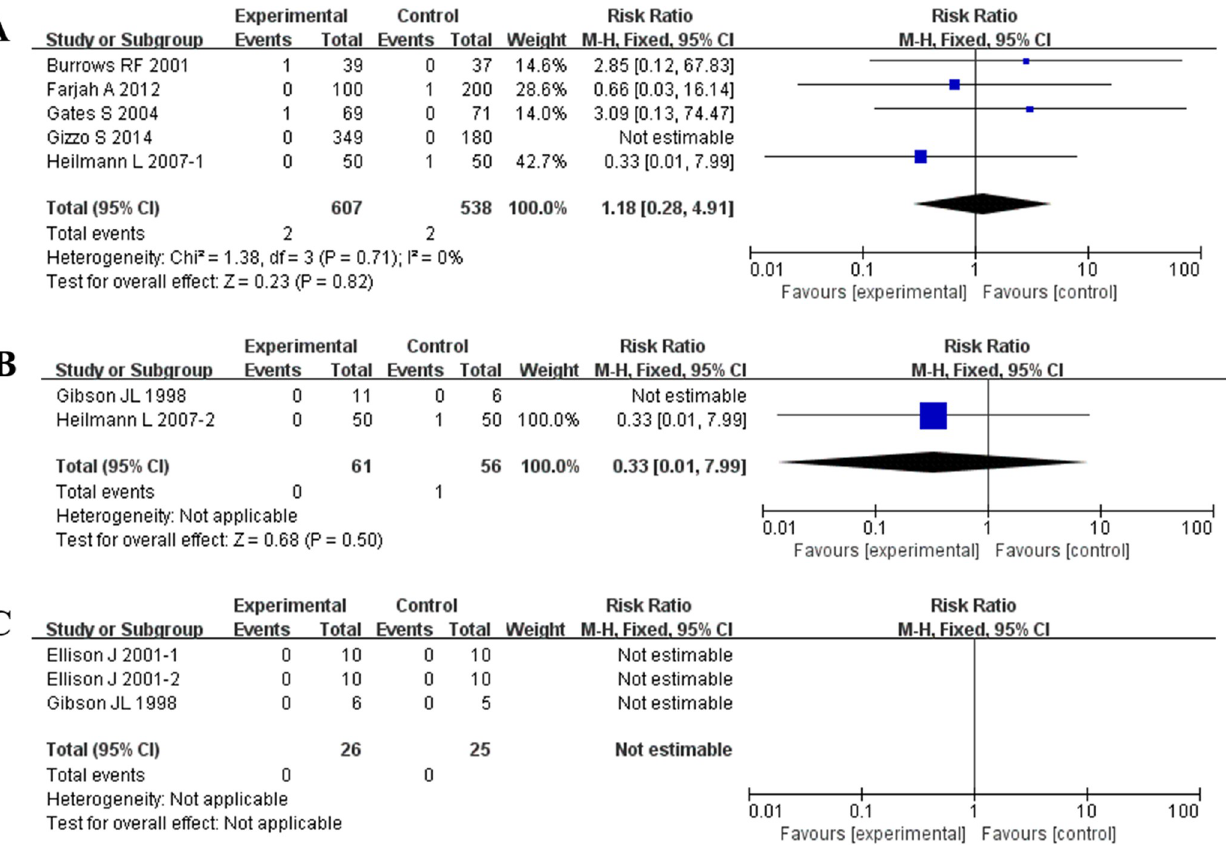
Fig 3. Effect of all studies in reducing the incidence of embolism. (A) LMWH versus negative control; (B) LMWH versus UFH; (C) LMWH versus LMWH.